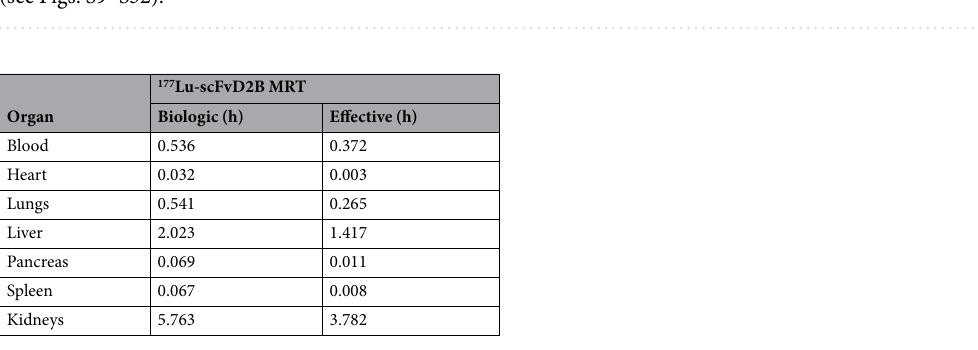
Figure 6. ( A ) SPECT/CT images of mice bearing LNCaP lung microtumors collected at different time points after injection of 37 MBq dose of 177 Lu-iPSMA (upper panels) and 177 Lu-scFvD2B (lower panels). Images are representative of one out three mice selected for each group. ( B ) 177 Lu-scFvD2B and 177 Lu-iPSMA tumor kinetic curves obtained from the pulmonary microtumors data. CT and SPECT single images, as well as axial and sagittal sections displaying the microtumor locations of each mouse, are shown in Supplementary Information (see Figs.